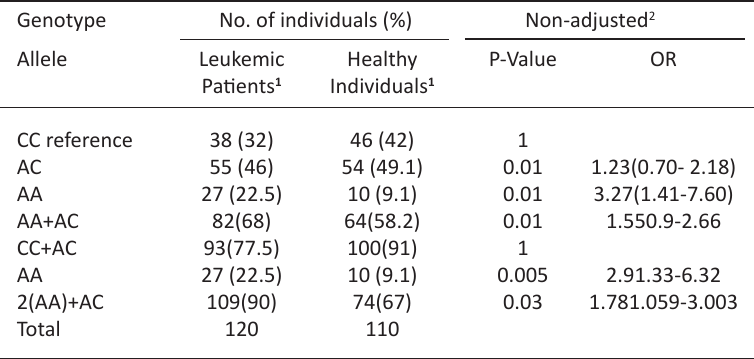
Table 2. Genotyping distribution of BCL2 (rs2279115; - 938 C>A) in leukemic and healthy subjects